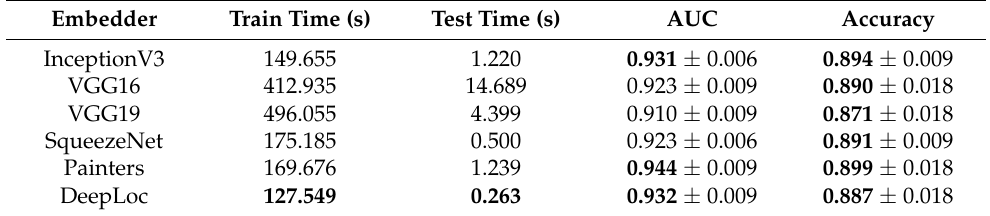
Table 5. Confusion matrix containing the results (percentage in relation to the prediction) of the test with the Painters embedder on the covmingrad image from the unfiltered pair of COSMO-SkyMed images. Covmingrad (Painters)